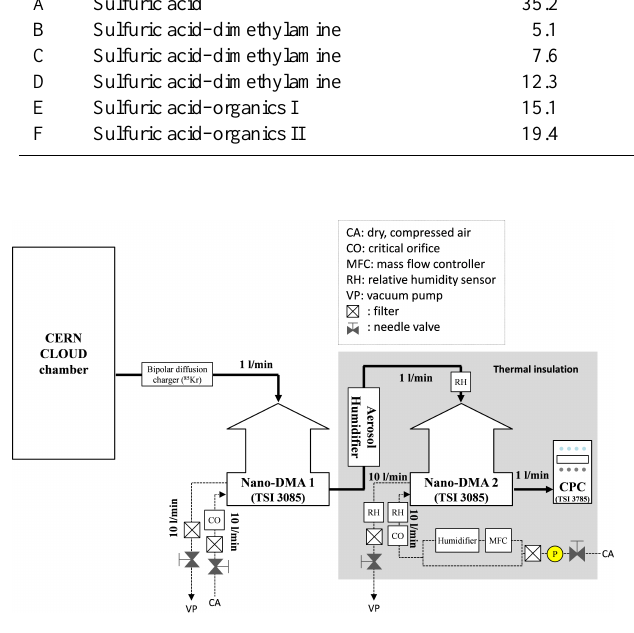
Figure 1. A schematic drawing of the nano-TDMA system used in this